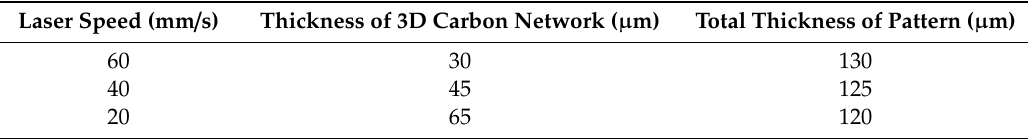
Table 4. Thickness of overlapped-pulse patterns.